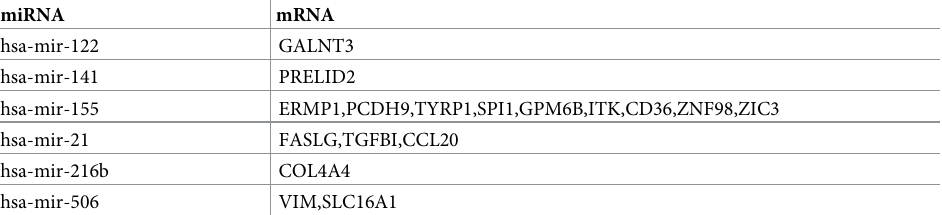
Table 6. Representative relationships between miRNAs and mRNAs in patients with kidney renal clear cell carcinoma. miRNA